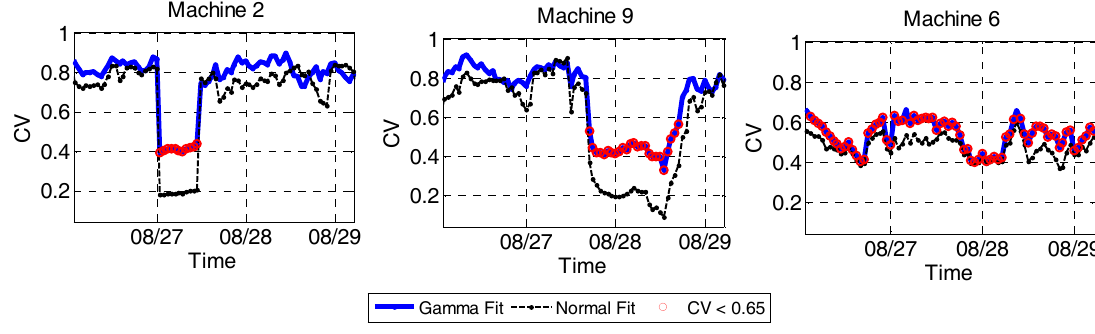
Figure 3. Calculated CV for three machines in stage 2 producing the same type of product [26].